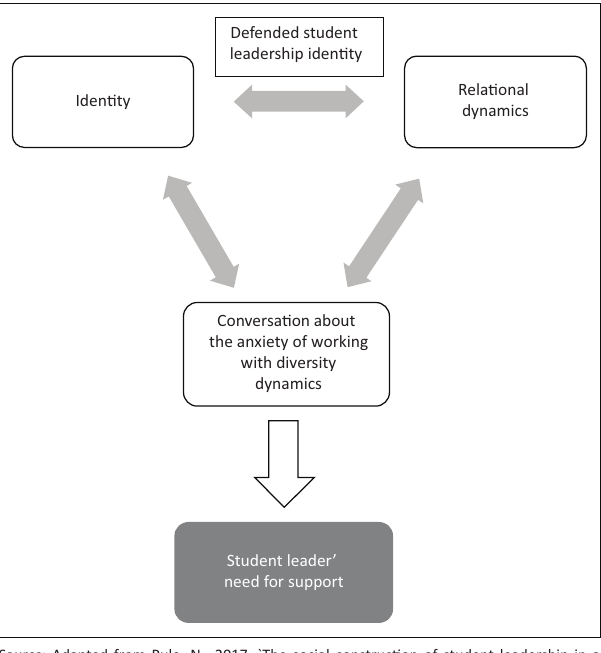
FIGURE 3: Integrated working hypothesis: The social construction of student leadership at a South African